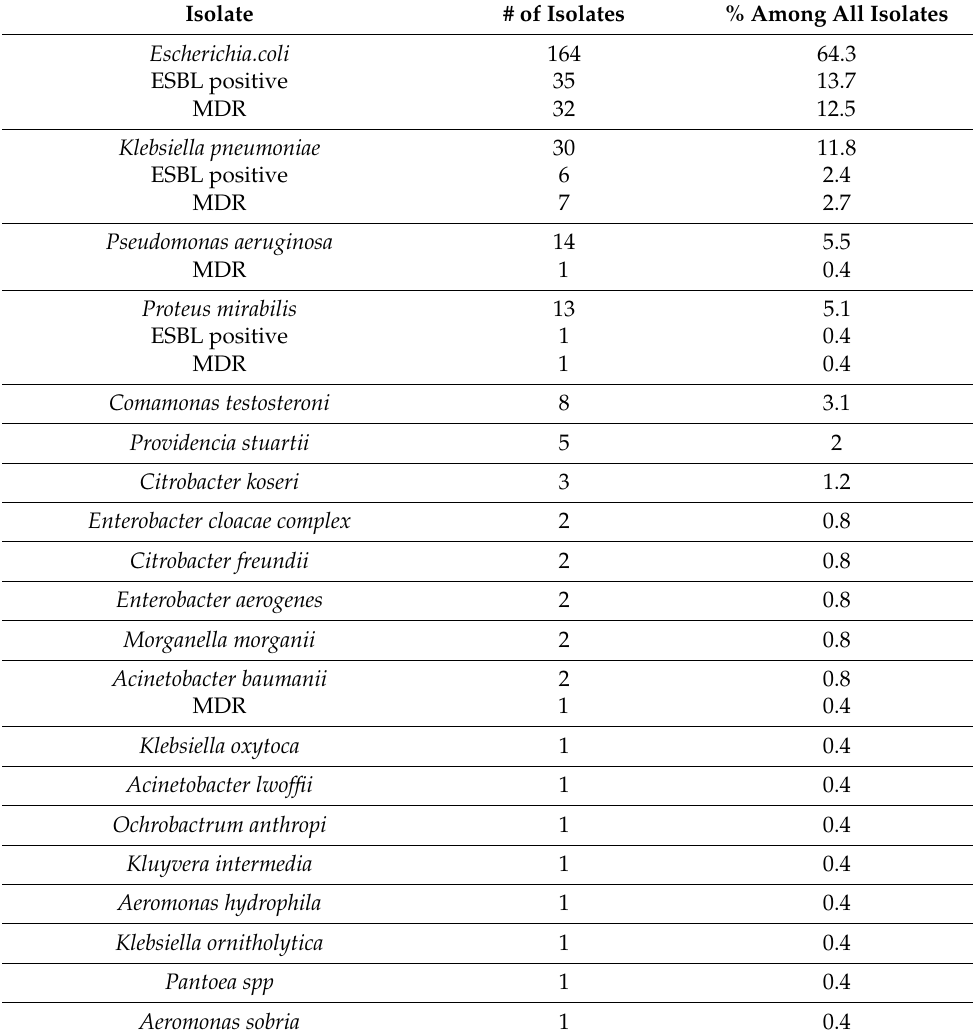
Table 1. Isolated microorganisms.